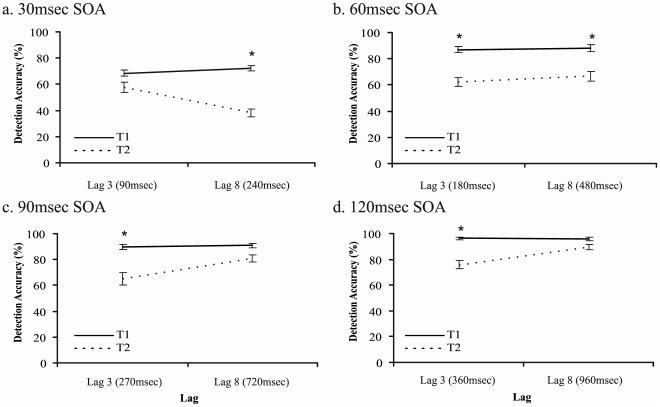
Target detection accuracy for T1 and T2.Accuracies are shown for lags 3 and 8 across four SOA conditions: 30 msec (a), 60 msec (b), 90 msec (c) and 120 msec (d). Asterisks indicate a significant difference between T1 and T2 detection accuracy. Error bars represent standard errors of the mean.